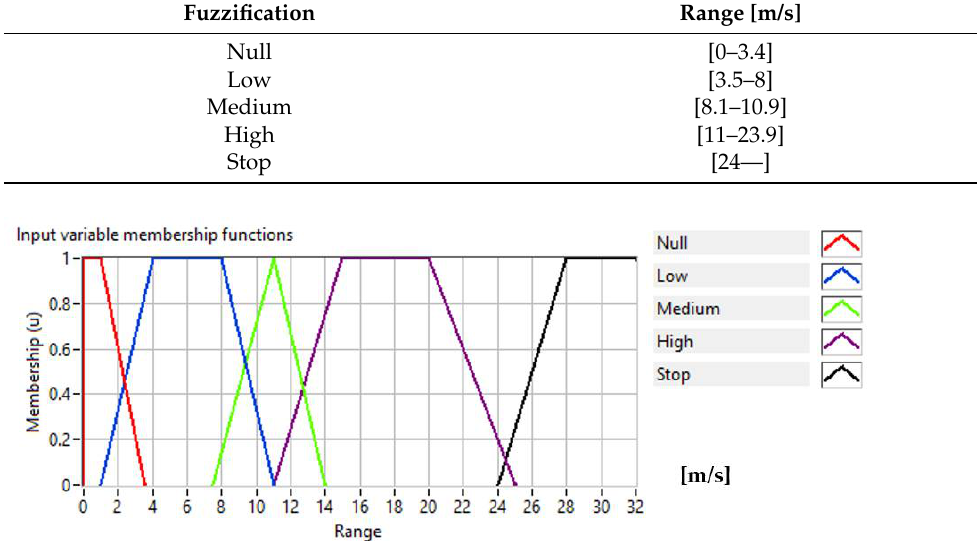
Figure 3. Membership functions of the wind speed input variable of the wind power plants belonging to the sample of the eastern region. X-axis range in (m/s).